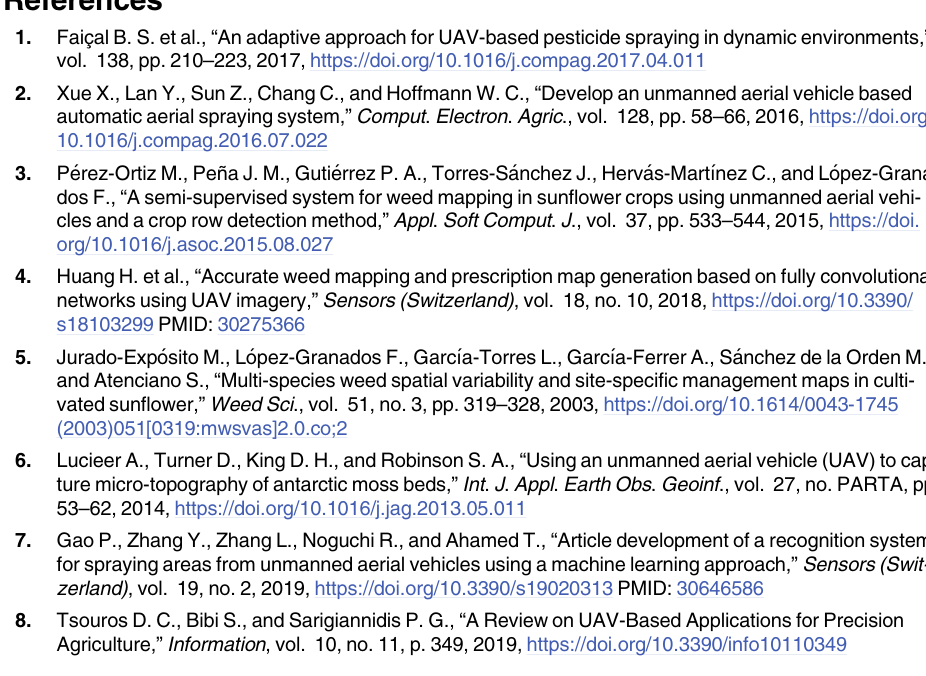
Fig 10. Comparison of developed system with individual systems for strawberry. a) Developed system vs KNN. b) Developed system vs SVM. c) Developed system vs LeNet5. d) Developed system vs VGG-11. e) Developed system vs VGG-16. f) Developed system vs ResNet18. g) Developed system vs